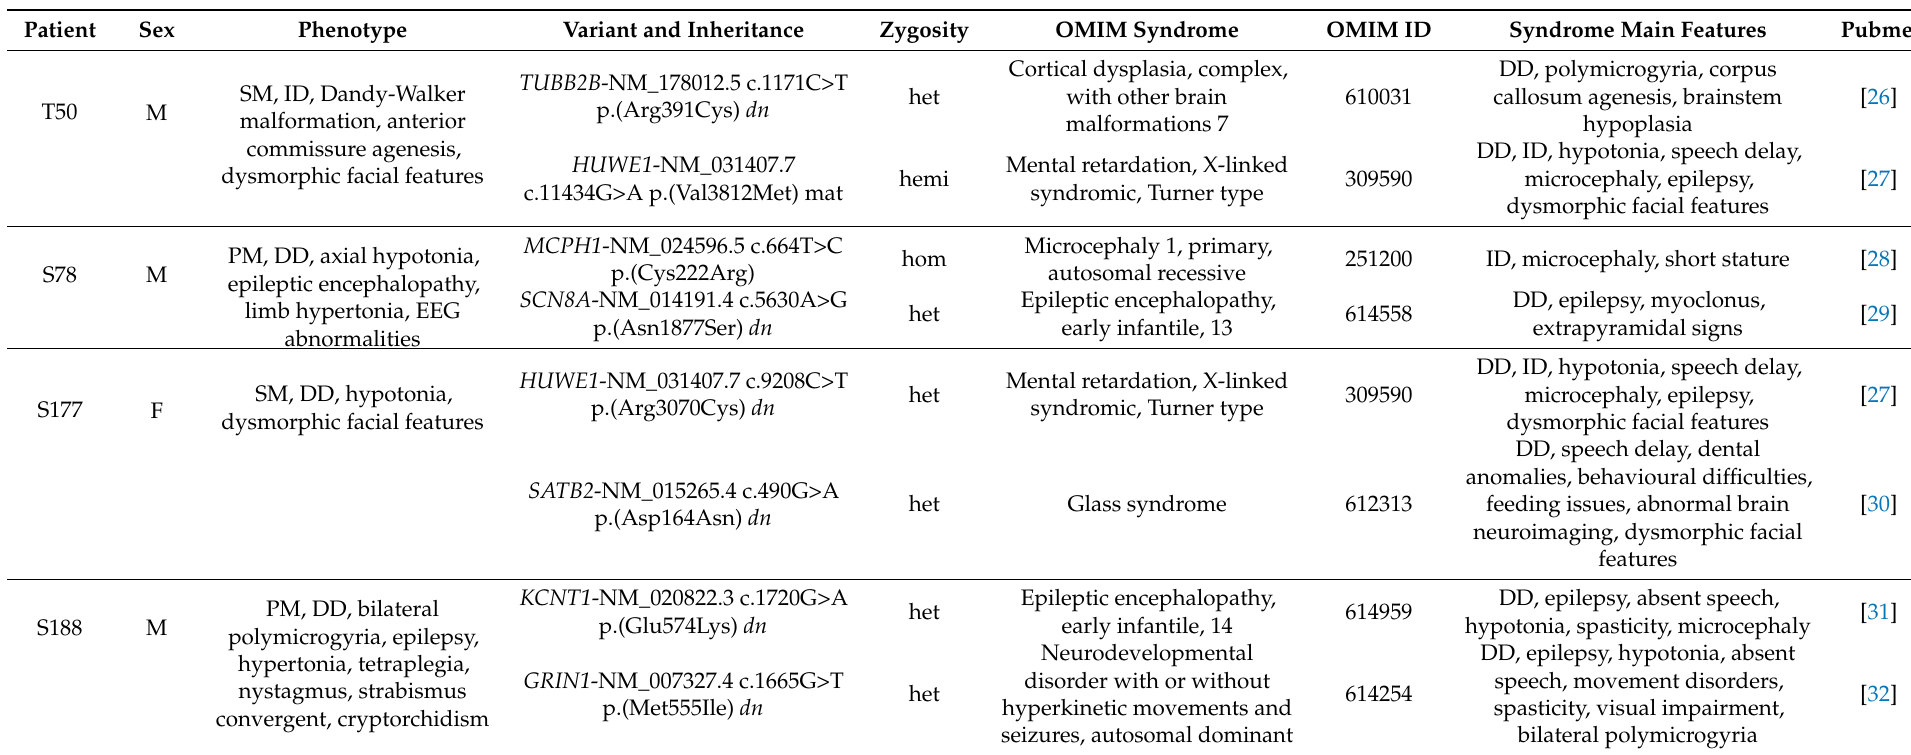
Table 2. Comparison of phenotype of patients with possible dual molecular diagnosis and most common clinical features of patients with mutations in those genes.